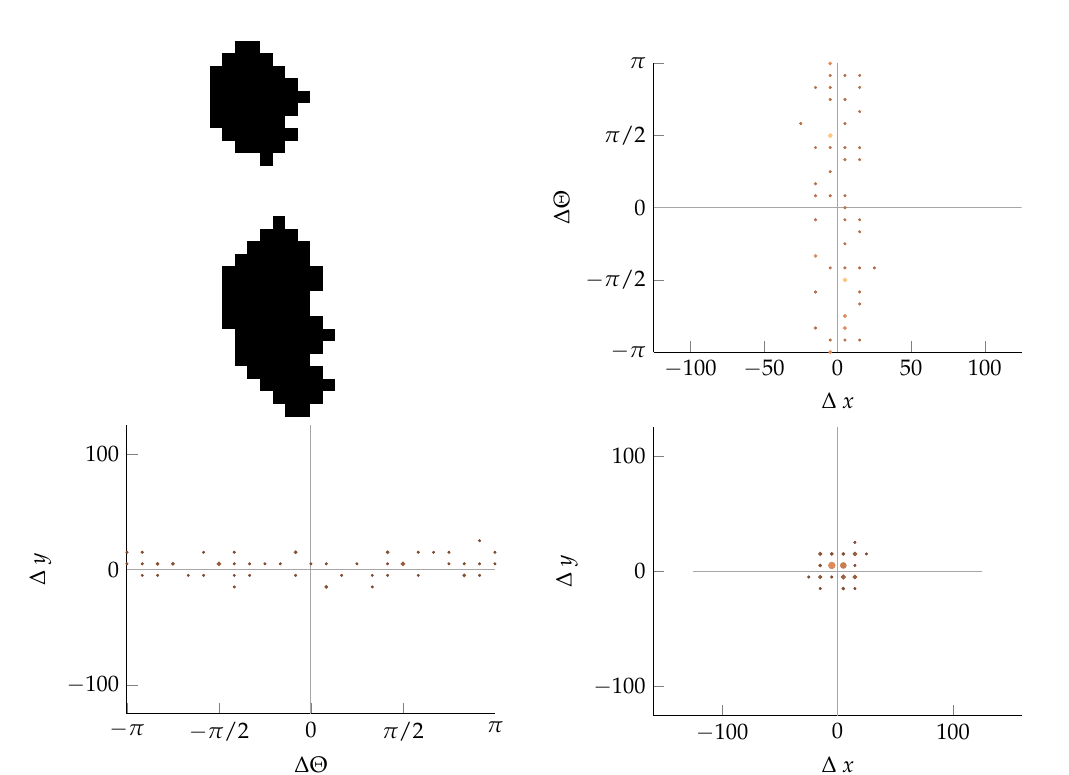
Figure B11. Monocot example 6.